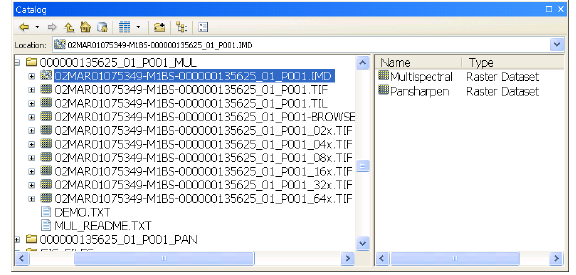
Figure 1. QuickBird raster